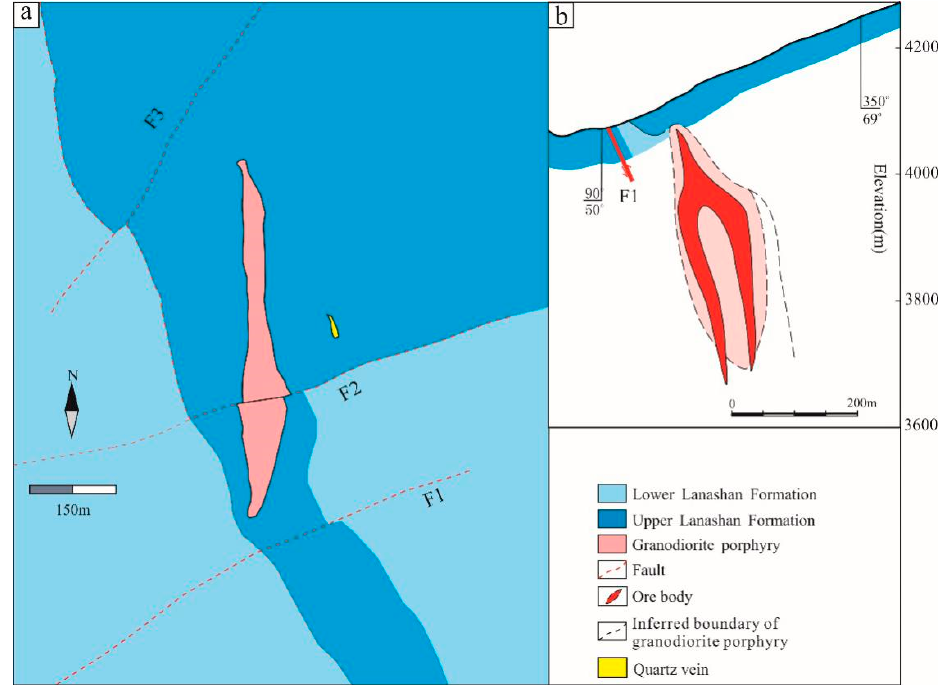
Figure 2. ( a ) Simplified geologic map of the Changdagou deposit (modified from [6]). ( b ) Geological profile for prospecting line No. 12 .